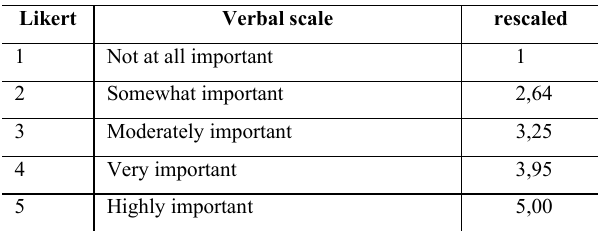
Table 1: Conversion of Likert scale